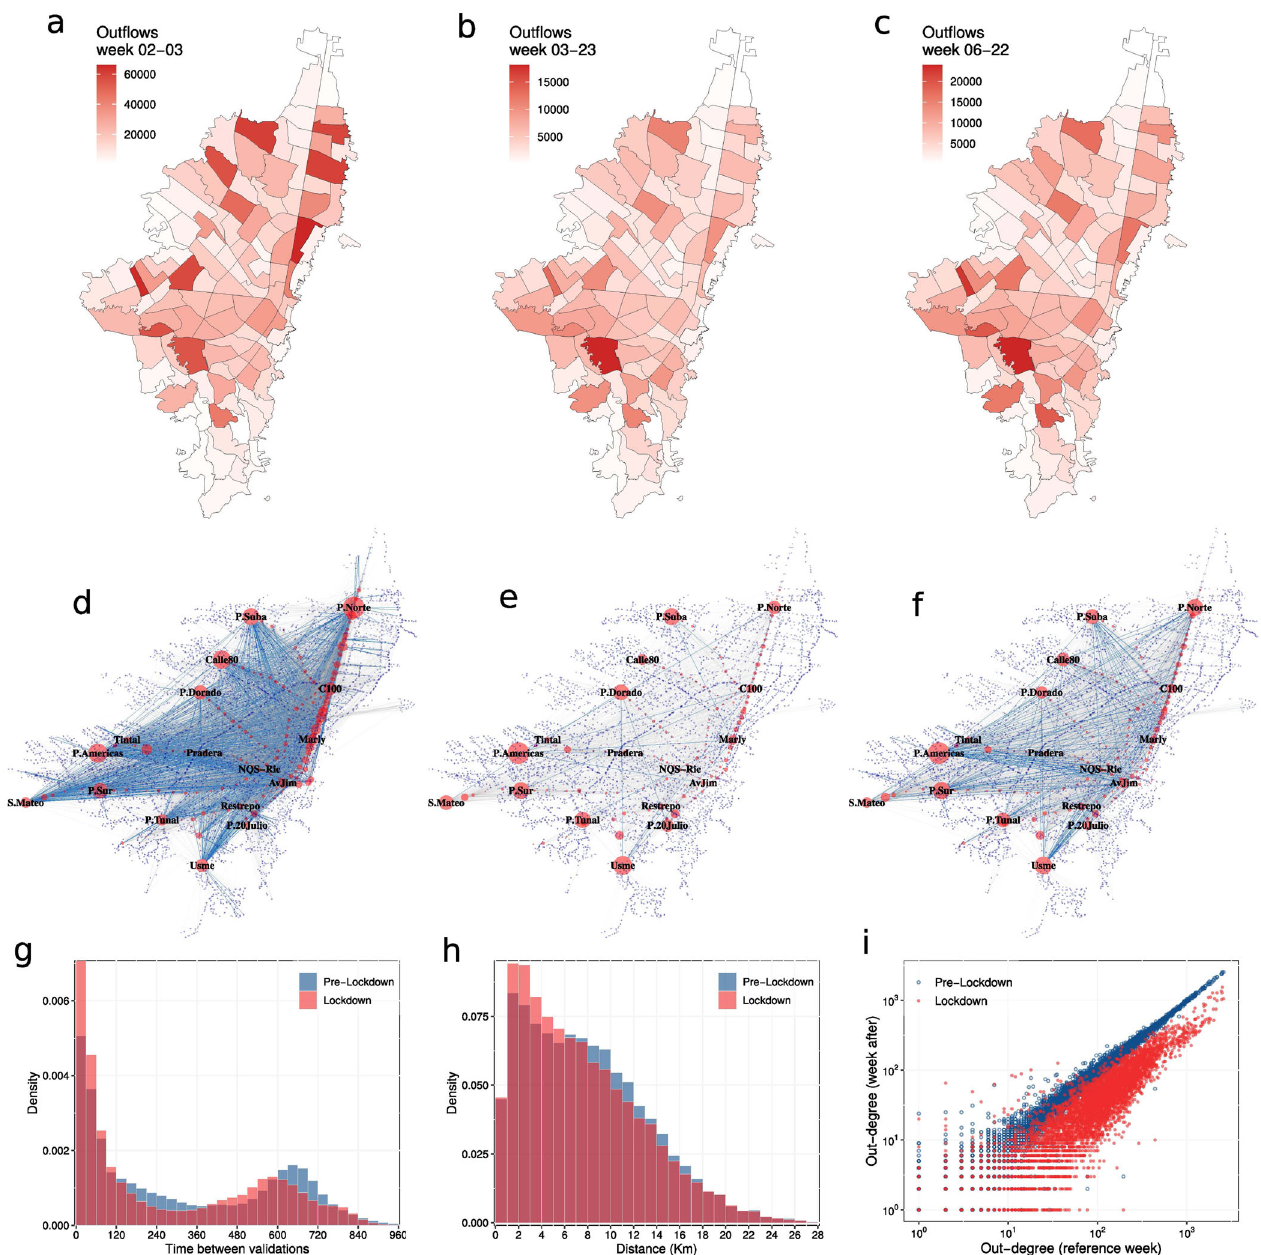
SITP, and in red to TM. Link weights < 10 are fi ltered out. Link weights ≥ 10 and < 200 are in grey. Link weights ≥ 200 are in blue. Mobility networks in different weeks: pre-lockdown or reference week (February 3), lockdown (March 23), and partial lockdown (June 22), respectively. g and h Time and distance distribution, respectively, between smart card validations at the integrated public transport system. Pre-lockdown and lockdown. (i) Correlation between out-degree in the reference week (February 3) and out-degree in pre-lockdown (February 10) and lockdown (March